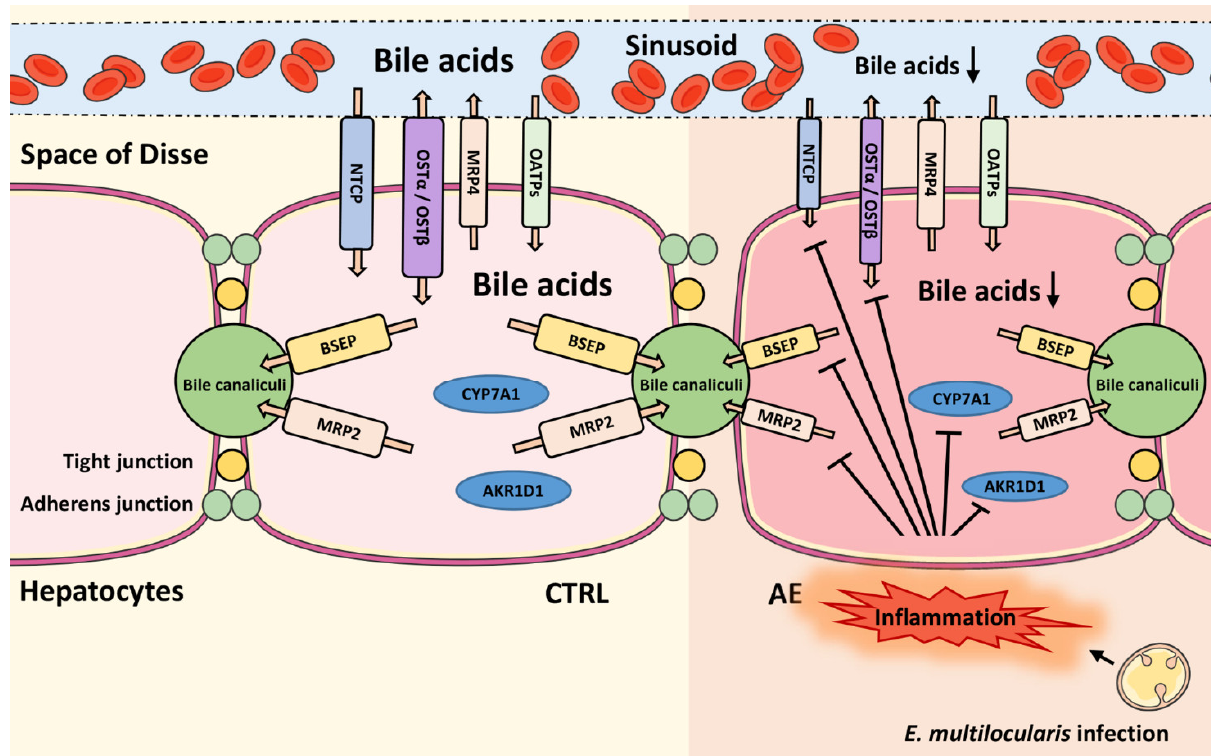
Figure 5. Schematic overview of key transport proteins involved in hepatic bile acid homeostasis. Left panel: situation in hepatocytes of control mice; right panel: model of the situation in hepatocytes in experimental murine alveolar echinococ- cosis (AE). The i.p. infection results in hepatic inflammation, suppressing the expression of the bile acid biosynthesis enzyme cytochrome P450 (CYP) 7A1 and aldo-keto reductase (AKR) 1D1 and of the bile salt transporters bile salt efflux mump (BSEP), multidrug resistance-associated protein (MRP) 2, Na+/taurocholate cotransporting polypeptide (NTCP), and organic solute transporters (OST)α (SLC51A) and OSTβ (SLC51B). OATPs, organic anion transporters; CTRL, control.